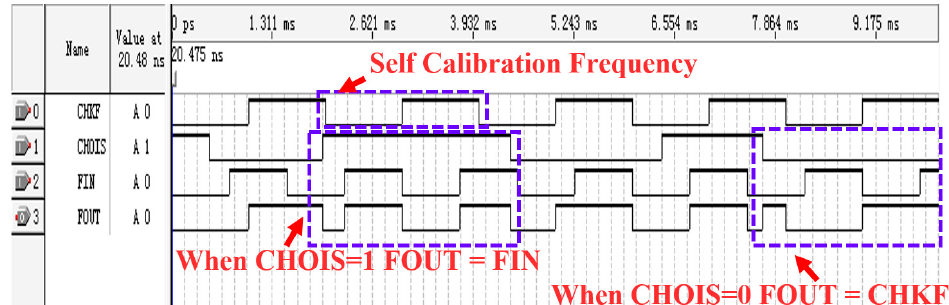
Figure 11. Self-calibration/test frequency selection circuit.